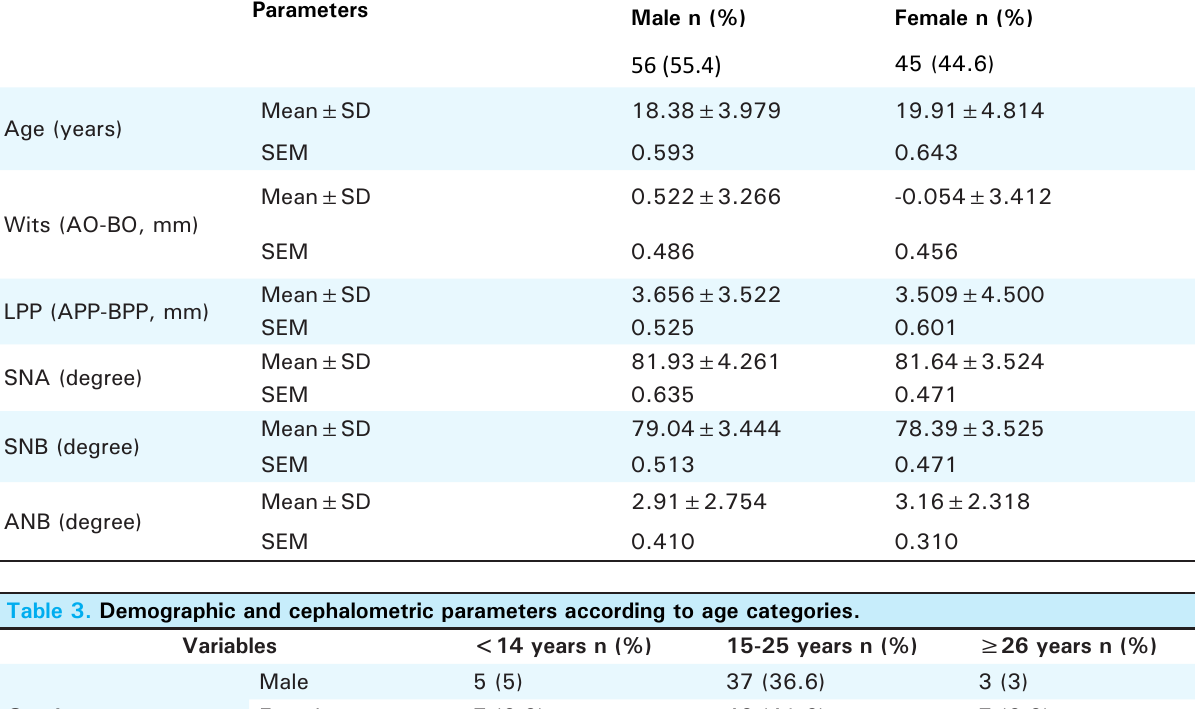
Table 3. Demographic and cephalometric parameters according to age